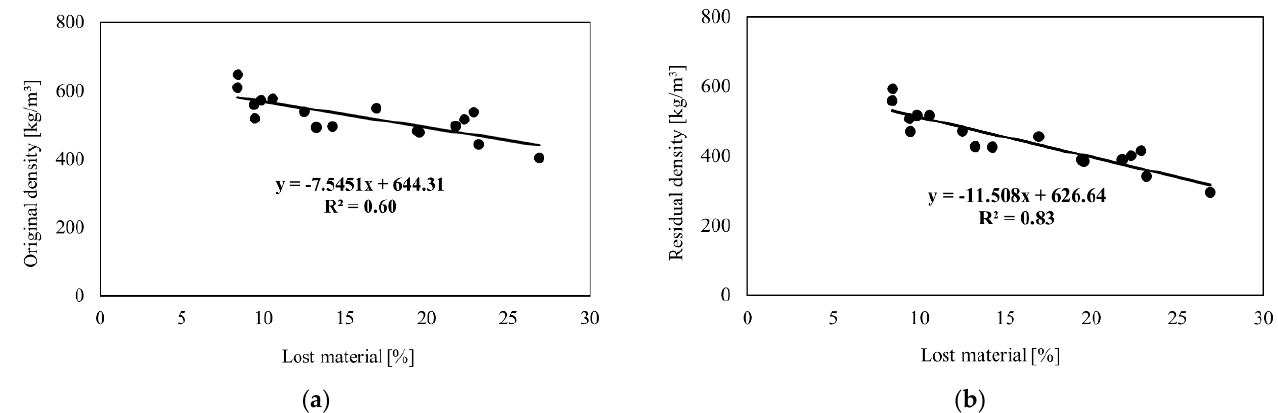
Figure 6. Correlations between lost material percentage (LM%) and timber apparent density, original (OTD) ( a ) and between LM% and timber apparent density, residual (RTD) ( b ) (adapted from [1]).